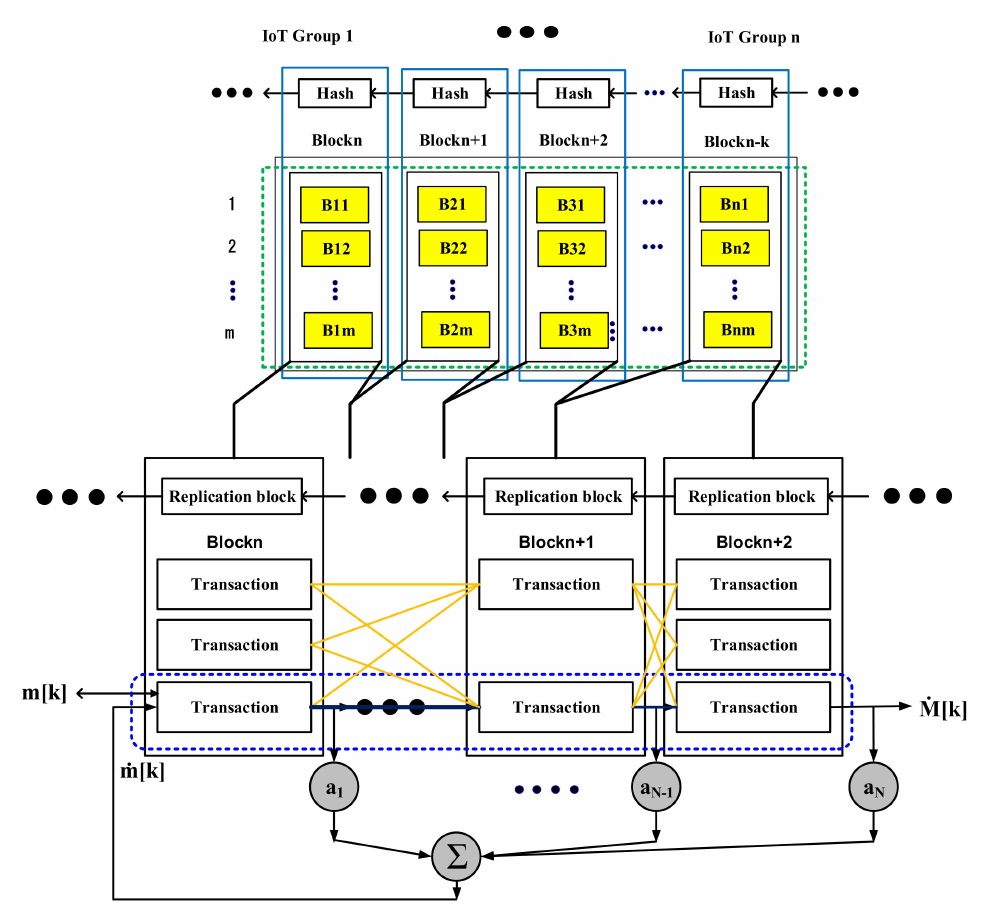
Figure 5. Blockchain-based multi-data connection